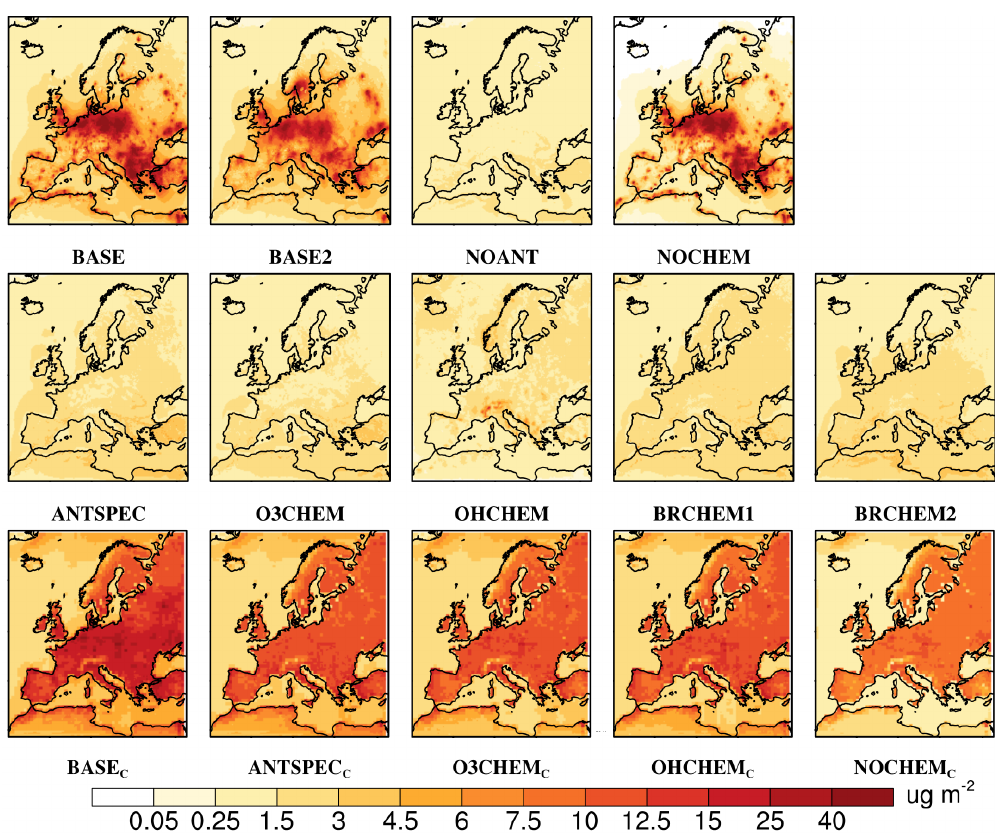
Figure 3. The total Hg dry deposition in the model experiments